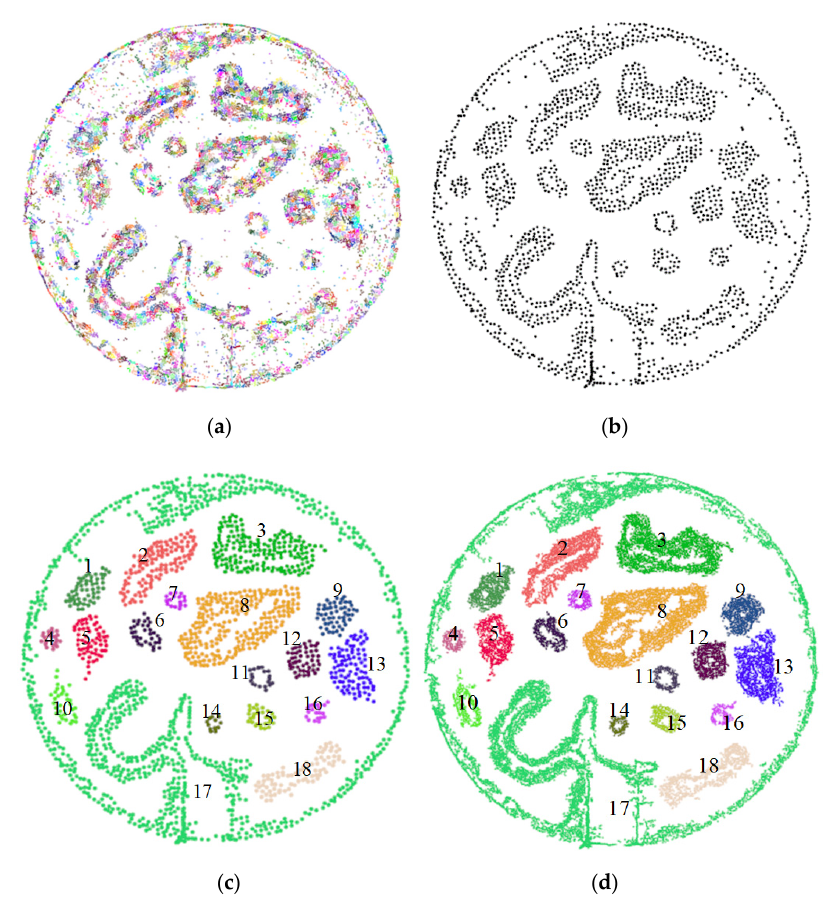
Figure 16. The process of clustering obstacles combined with super-voxel segmentation. ( a ) Super-voxel segmentation results; ( b ) center of gravity point cloud; ( c ) center of gravity point cloud clustering results; ( d ) obstacle point cloud clustering results.